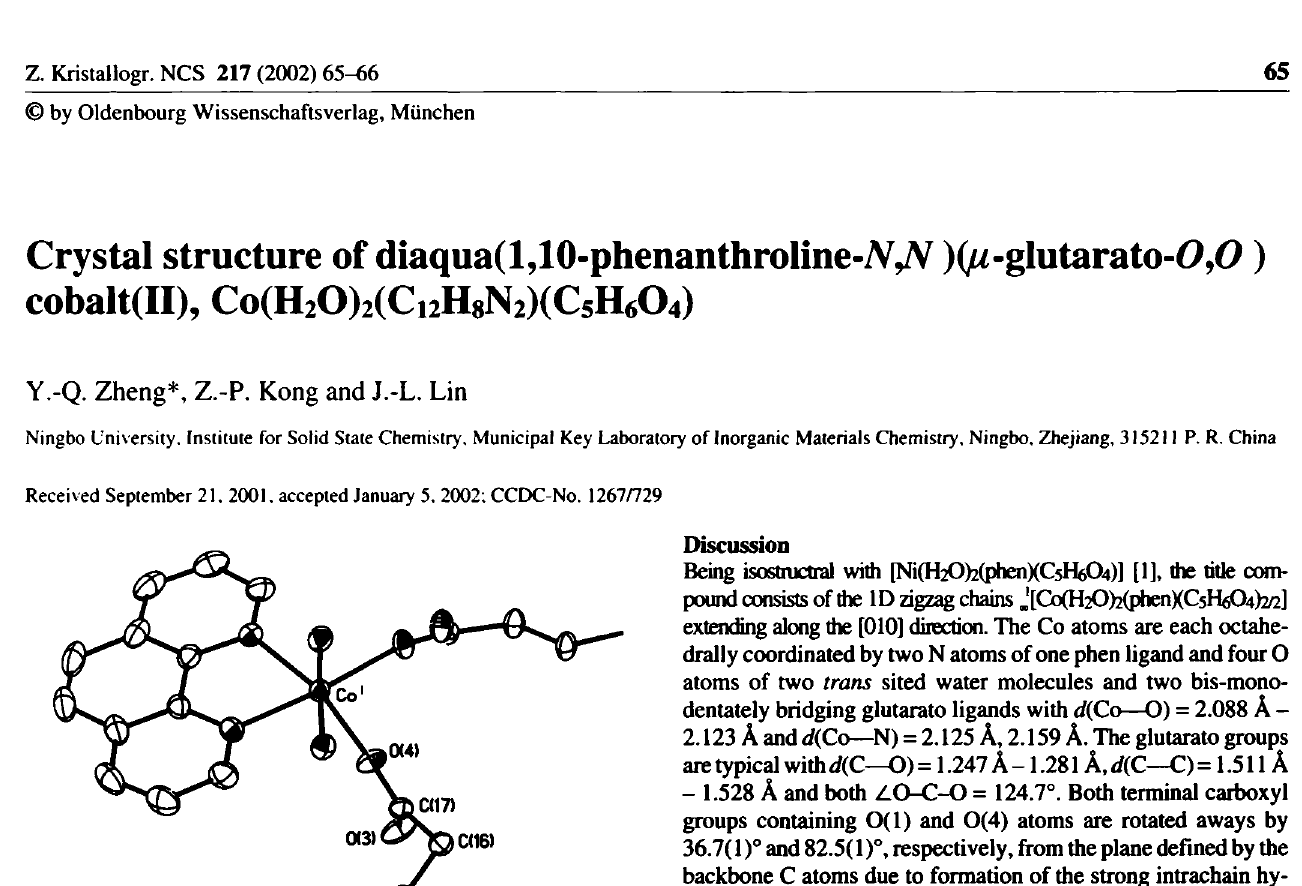
atoms of two trans sited water molecules and two bis-mono-